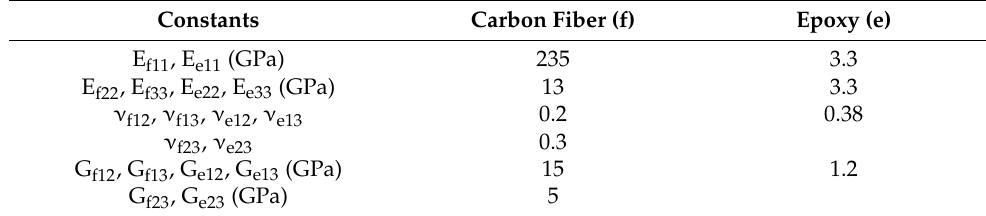
Table 3. Material constants of the fiber and